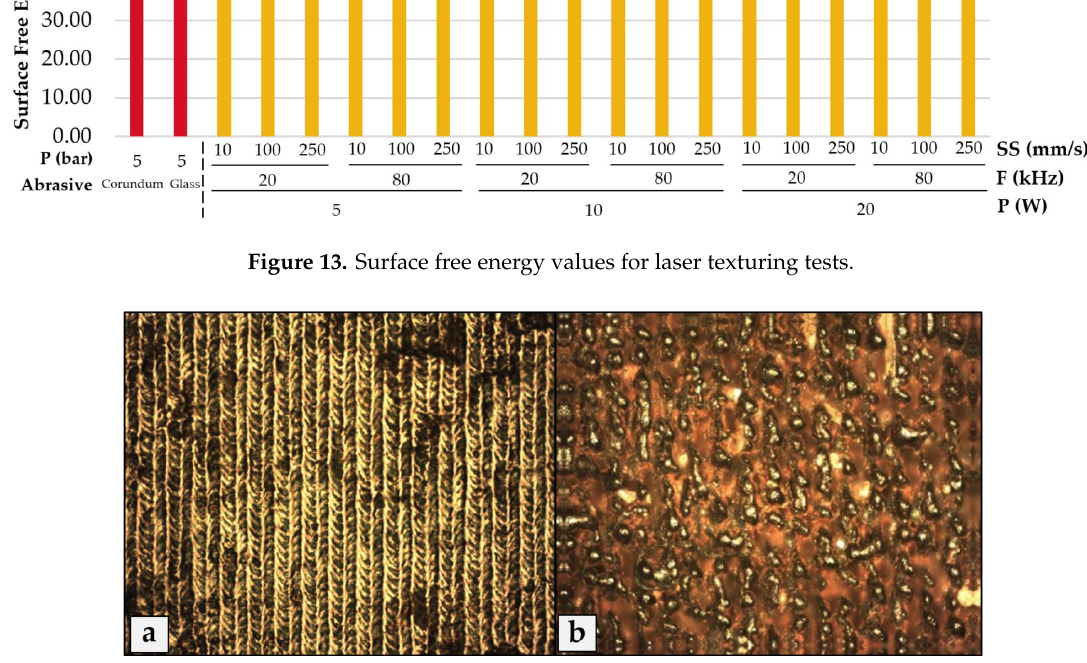
Table 8. ANOVA analysis of the free surface energy obtained in laser texturing.